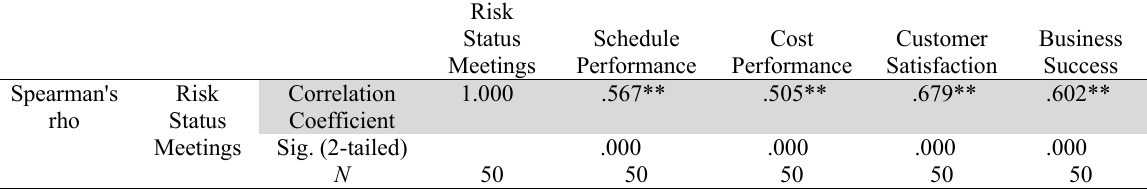
Correlations: Risk Status Meetings and Project Success Outcomes (Schedule Performance, Cost Performance, Customer Satisfaction, and Business